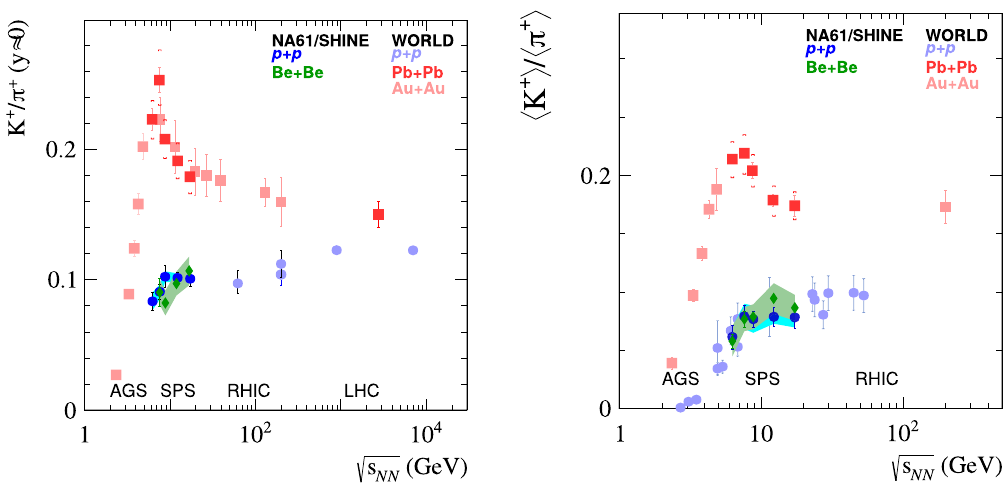
Fig. 33 The energy dependence of the K + / π + particle yields ratio at mid-rapidity (left) and full acceptance (right) for the 20% most central Be+Be, central Pb+Pb and Au+Au collisions, as well as inelastic p+p interactions. Both statistical (vertical bars) and systematic uncertainties (shaded bands) are shown